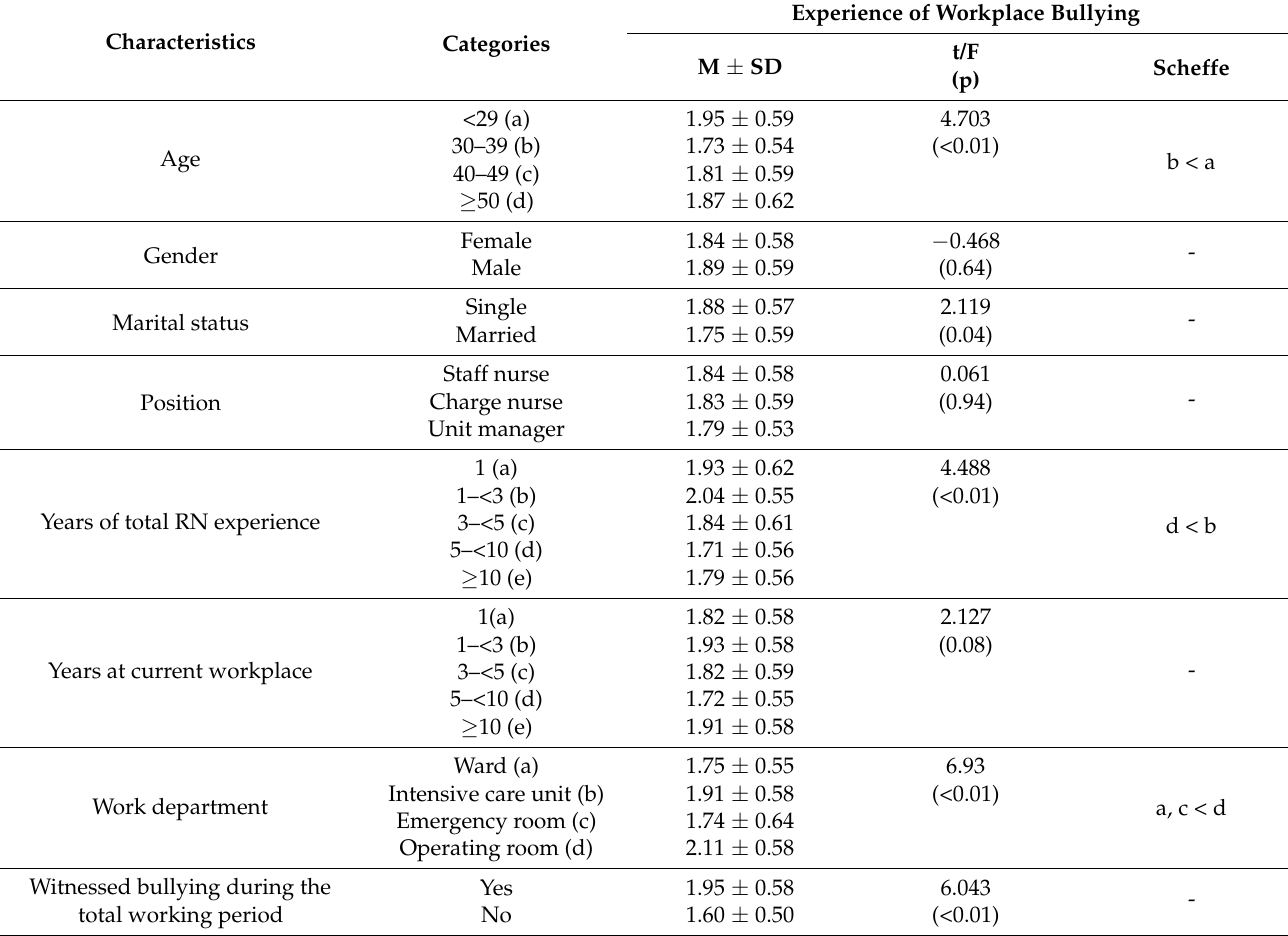
Table 2. Differences in experiences of workplace bullying by participant characteristics ( n =